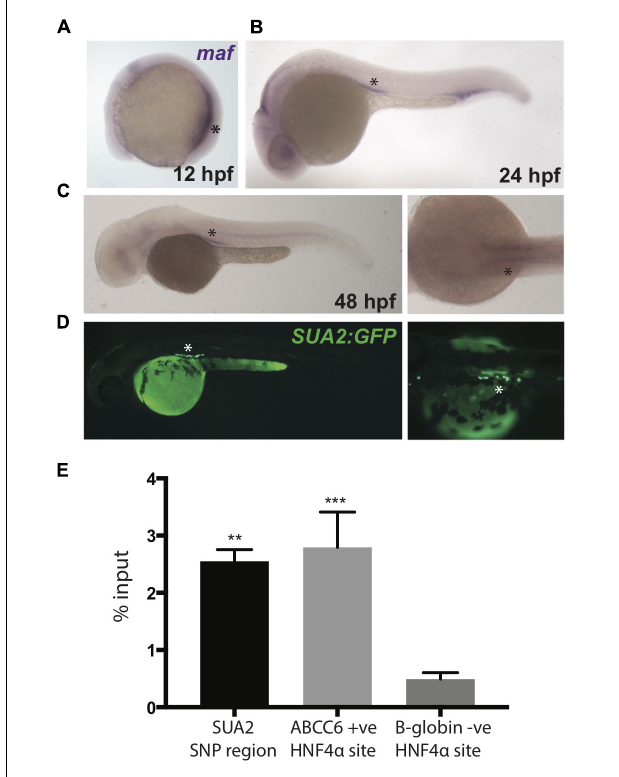
FIGURE 4 | Zebrafish maf coincides with SUA2 enhancer activity. (A–C) Whole mount in situ hybridization with a riboprobe detecting zebrafish maf was performed on wild type embryos at 12, 24, and 48 hpf. maf expression is present in the pronephros at 12 hpf and the proximal tubules at 24 and 48 hpf. (D) The SUA2 SNP region drives expression of GFP in the proximal tubules at 48 hpf. (E) ChIP analysis of the HNF4 α binding site at the SUA2 SNP region, a positive HNF4 α site at ABCC6 and a negative HNF4 α site at B-globin . Binding is shown relative to input chromatin. Bar graphs represent mean from three independent experiments. A one-way ANOVA test indicates a significant difference between the means of the SUA2 SNP region and the negative binding site in B-globin . There is no difference between the positive ABCC6 site and the SUA2 SNP region. Error bars denote standard error of the mean and asterisks indicate significance: ∗ p < 0.005; ∗∗ p < 0.005, ∗∗∗ p <